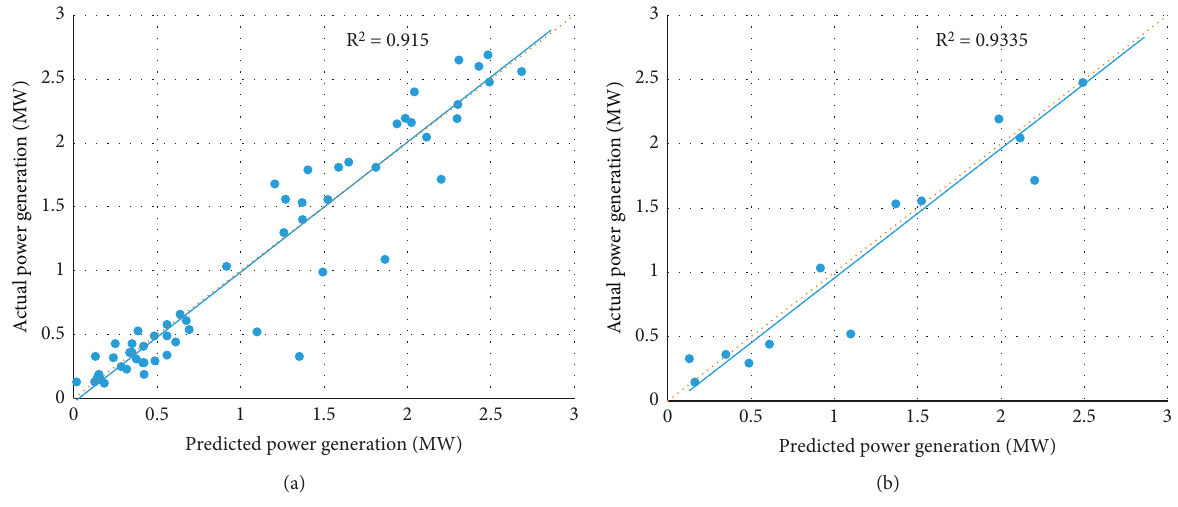
Figure 6: Actual vs predicted power generation. (a) For training and (b) for test. Table 3: Parameters for accuracy of the model.